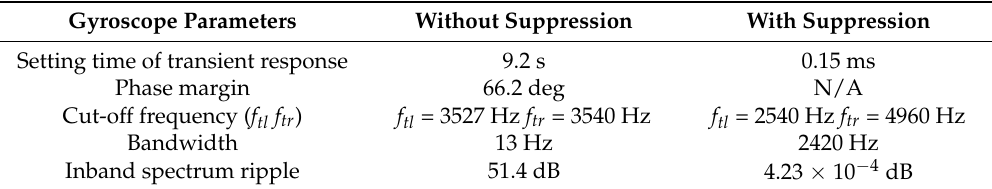
Table 3. Comparison results with and without oscillation suppression.